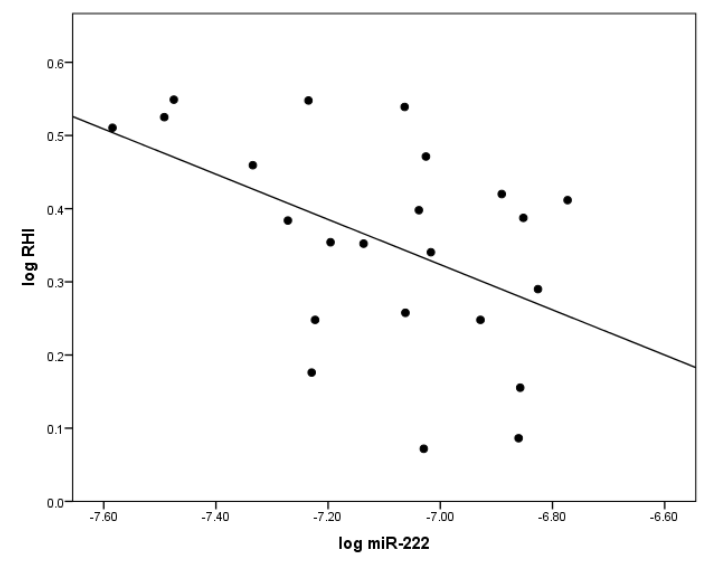
Figure 2. The significant correlation between levels of circulating miR‐222 and indices of vascular health in patients with T1DM at baseline. LogmiR‐222 was inversely correlated with endothelial function logRHI measured by the reactive hyperemia index (RHI). This relationship was demonstrated by Pearson correlation.